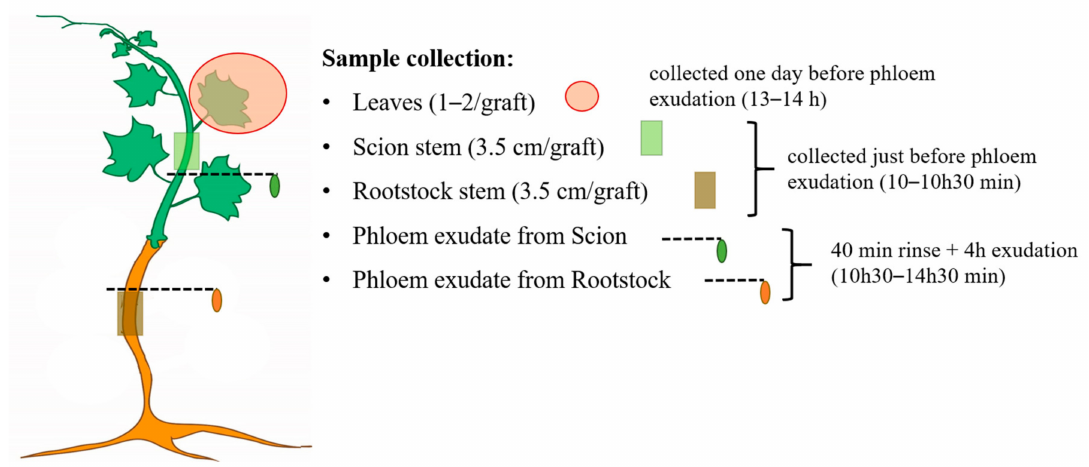
Figure 6. Sample collection scheme. Per graft combination one to two leaves, a segment of 3.5 cm of the scion stem, and 4 h of phloem exudate were collected from scions at 5–6 months after grafting. Rootstock stem samples were harvested from stem segment (length of 3.5 cm) and phloem exudate were collected for 4 h. Leaves were collected one day before phloem exudation to permit the plant to recover. Each sample type was collected at the same circadian